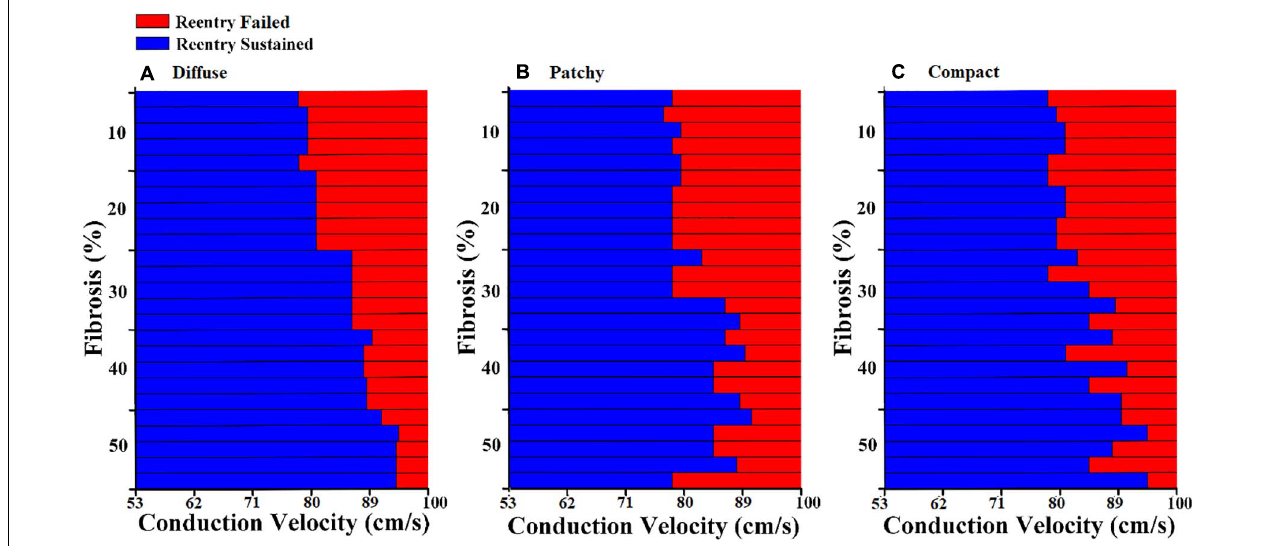
FIGURE 4 | Conduction delay owing to fibrosis distribution and fibrosis amount of (A) diffuse fibrosis, (B) patchy fibrosis, and (C) compact fibrosis.